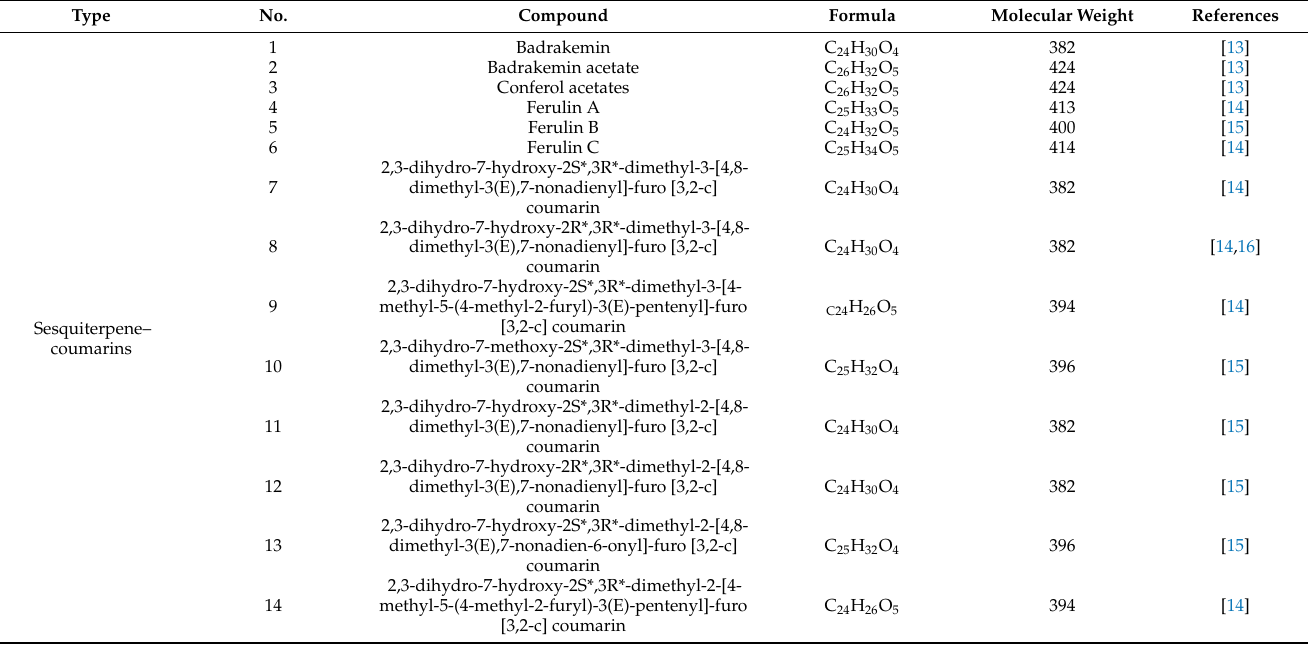
Table 1. Terpenoid Derivatives from Fructus F.